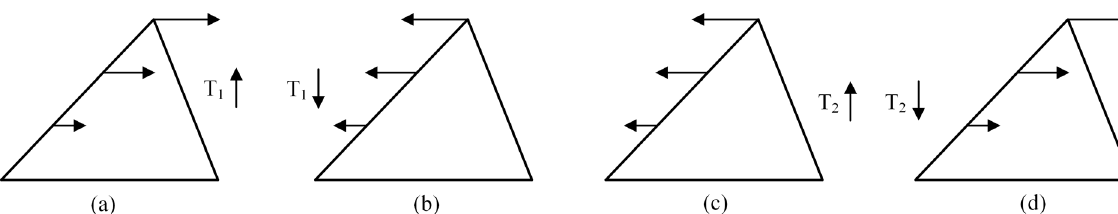
Figure 14. Measured temperature component and air temperature at PL13-1.